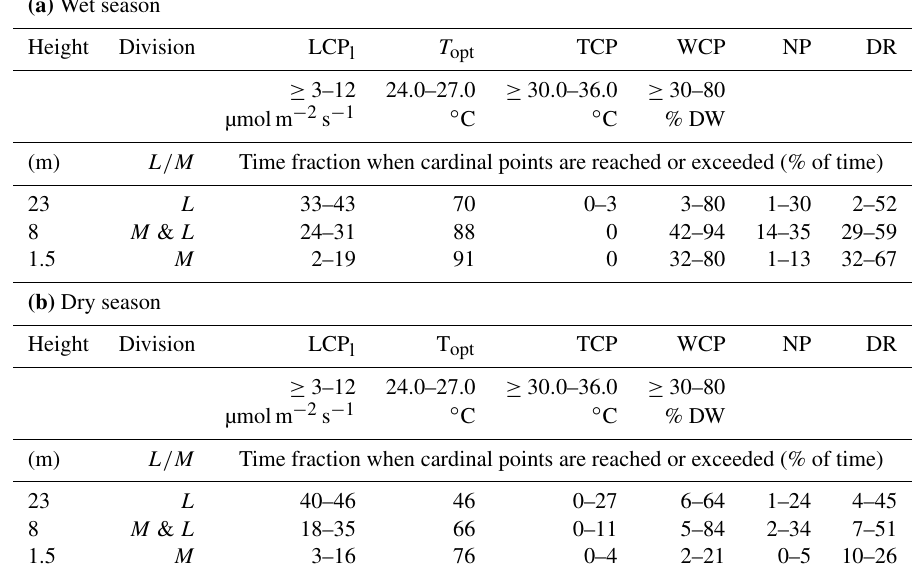
Table 3. The potential time fractions (%) during which the epiphytic bryophytes at the different height levels exceeded the lower compen- sation points of light (LCP l ), the upper compensation points for temperature (TCP), and the lower compensation points for water (WCP) and reached the optimal temperature for net photosynthesis ( T opt ). The results are shown separately for (a) the wet season (February–May) and (b) the dry season (August–November). Values are given for the different height levels (1.5, 8, 23m) and bryophyte divisions ( M = moss, L = liverwort). For the net photosynthesis (NP) it is required that WC > WCP, PAR > LCP l , and T <TCP; for the dark respiration (DR) it is necessary that WC > WCP and PAR <LCP l or WC > WCP and T > TCP; 30min averages of measurements during the entire measurement period from October 2014 to November 2016 were considered. The data show the averages of the different samples per height zone. The ranges of the compensation points (CPs) and the optimum temperature (opt) were reported in Lösch (1994) and Wagner et al. (2013; see Table